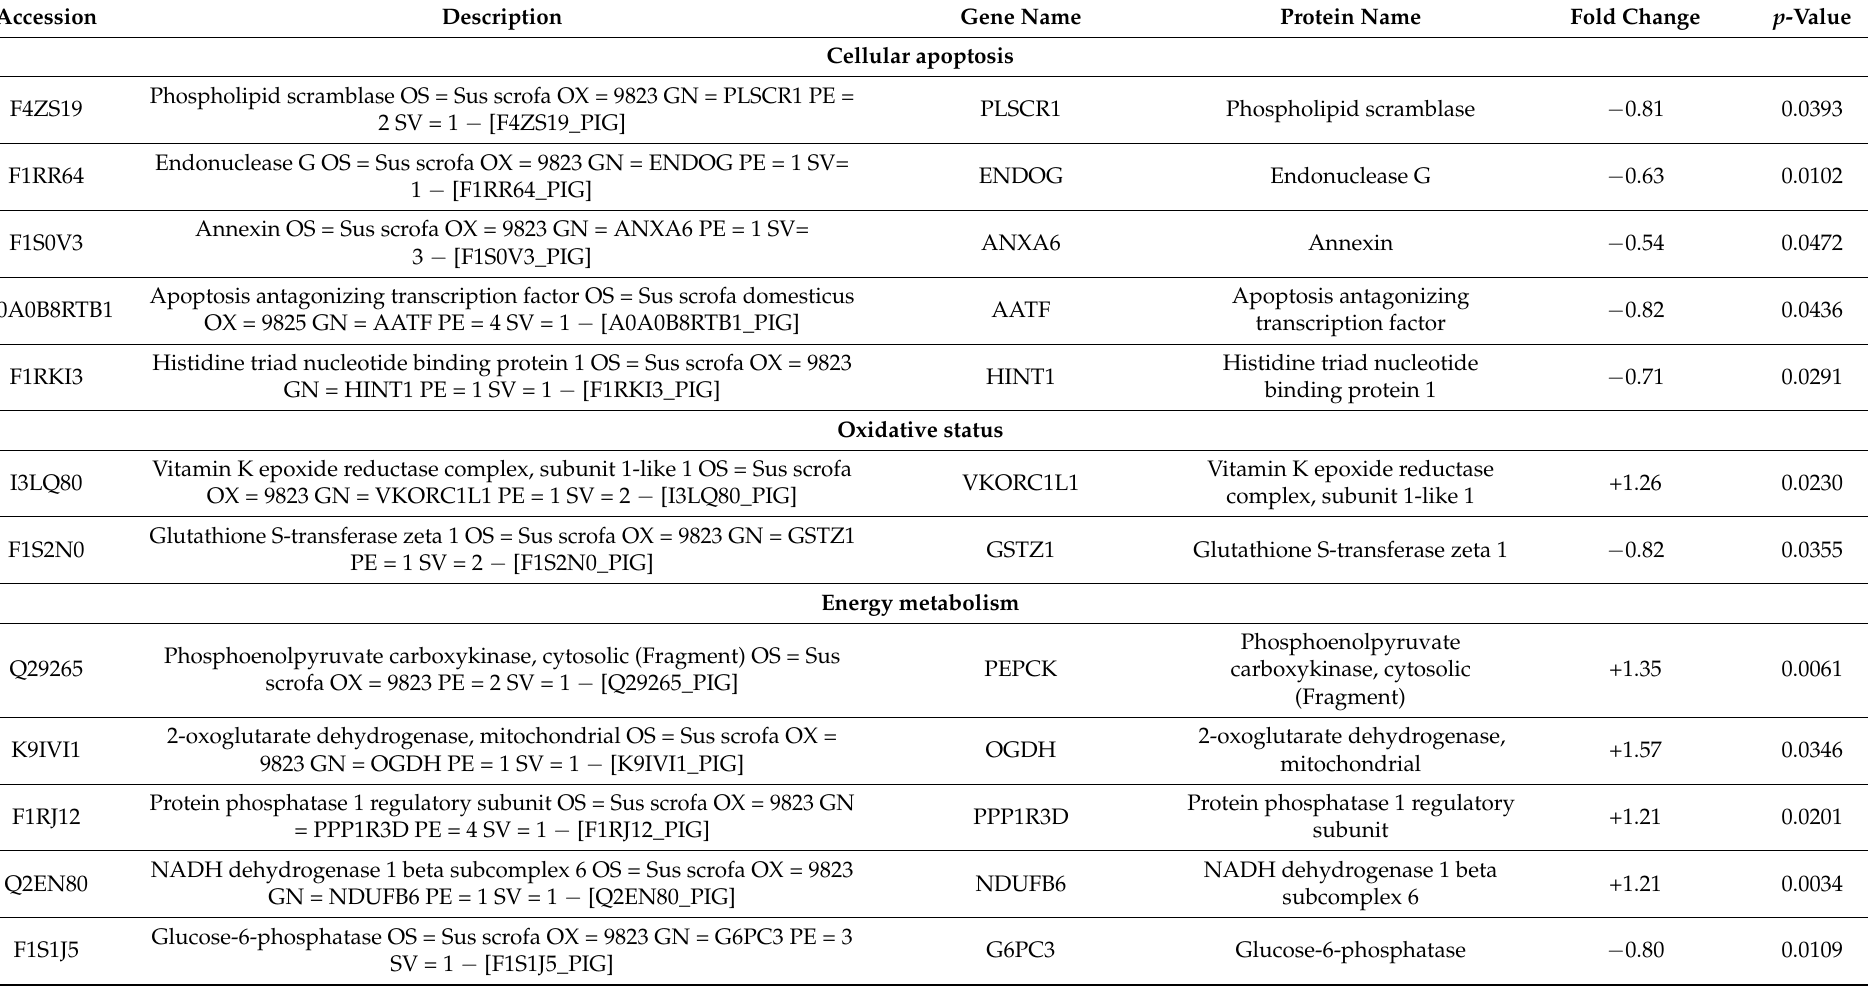
Table 5. Biochemical information about proteins differentially expressed in the ileum of newborn